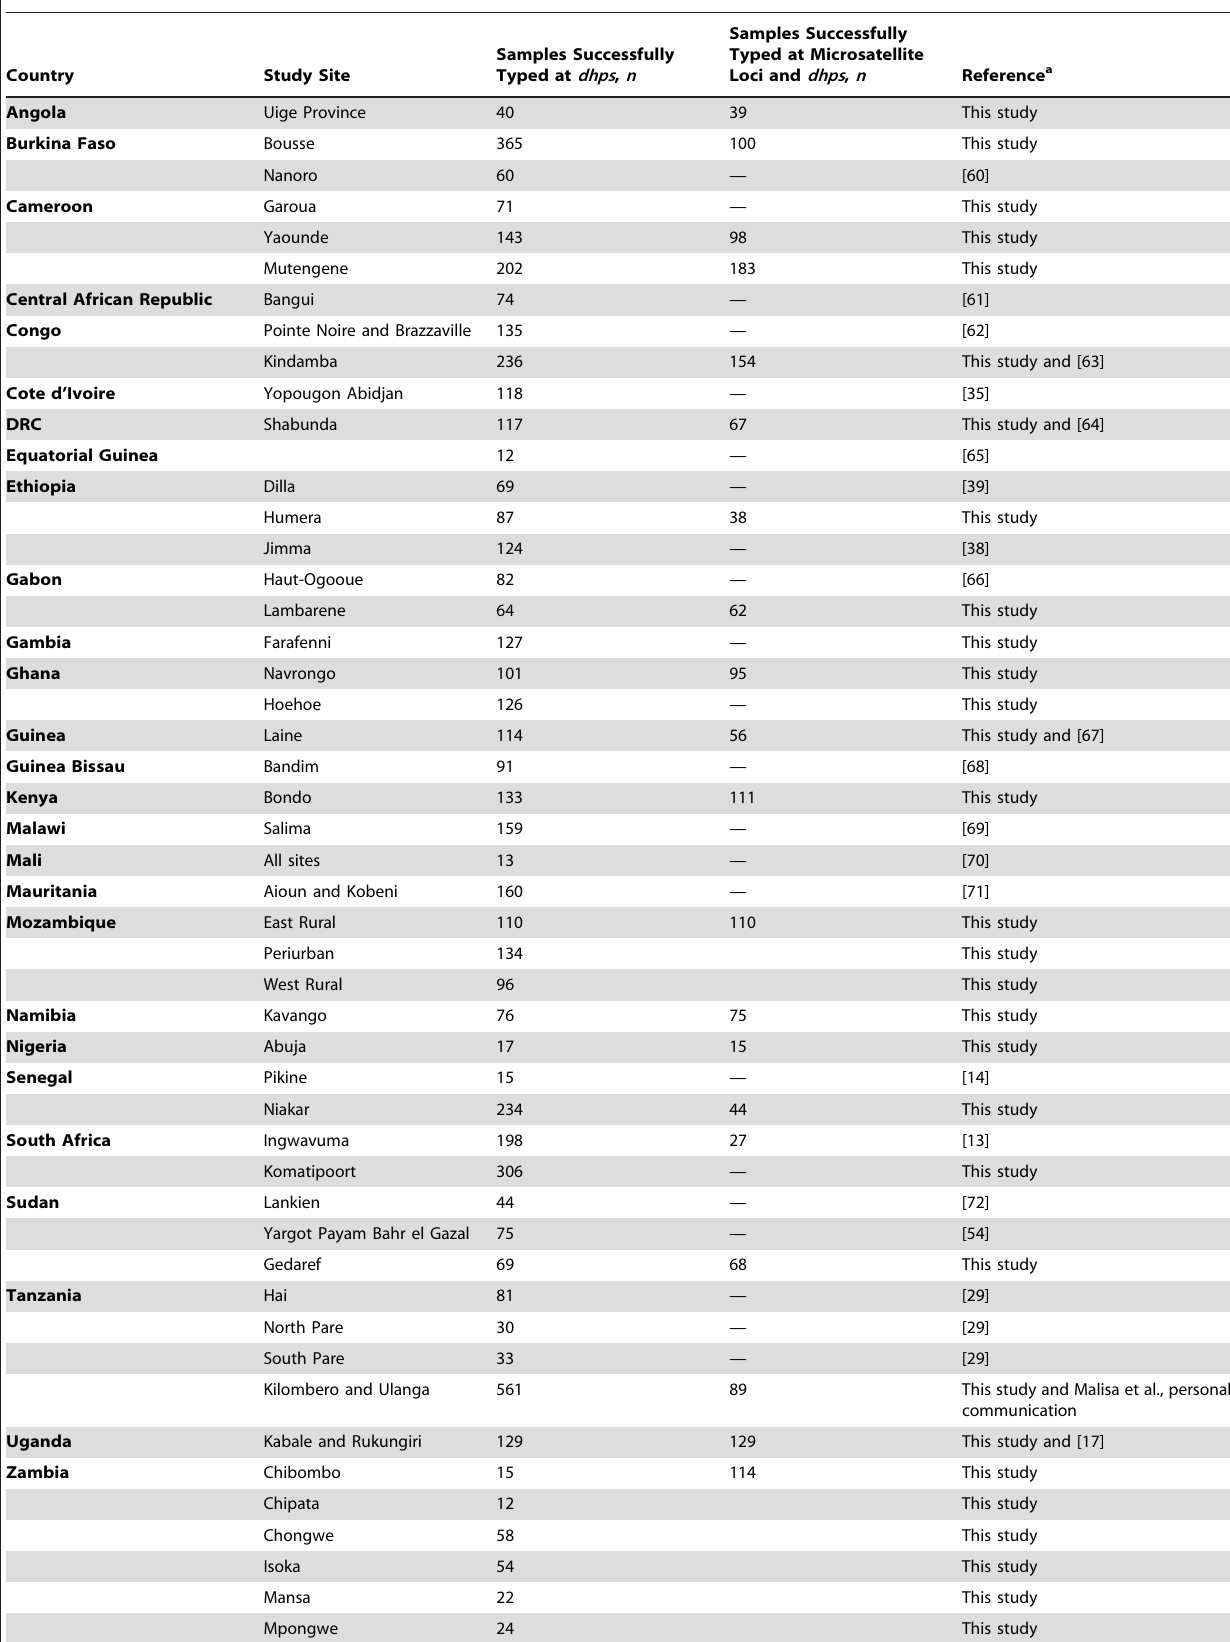
Table 1. Study site details and numbers of data points included.